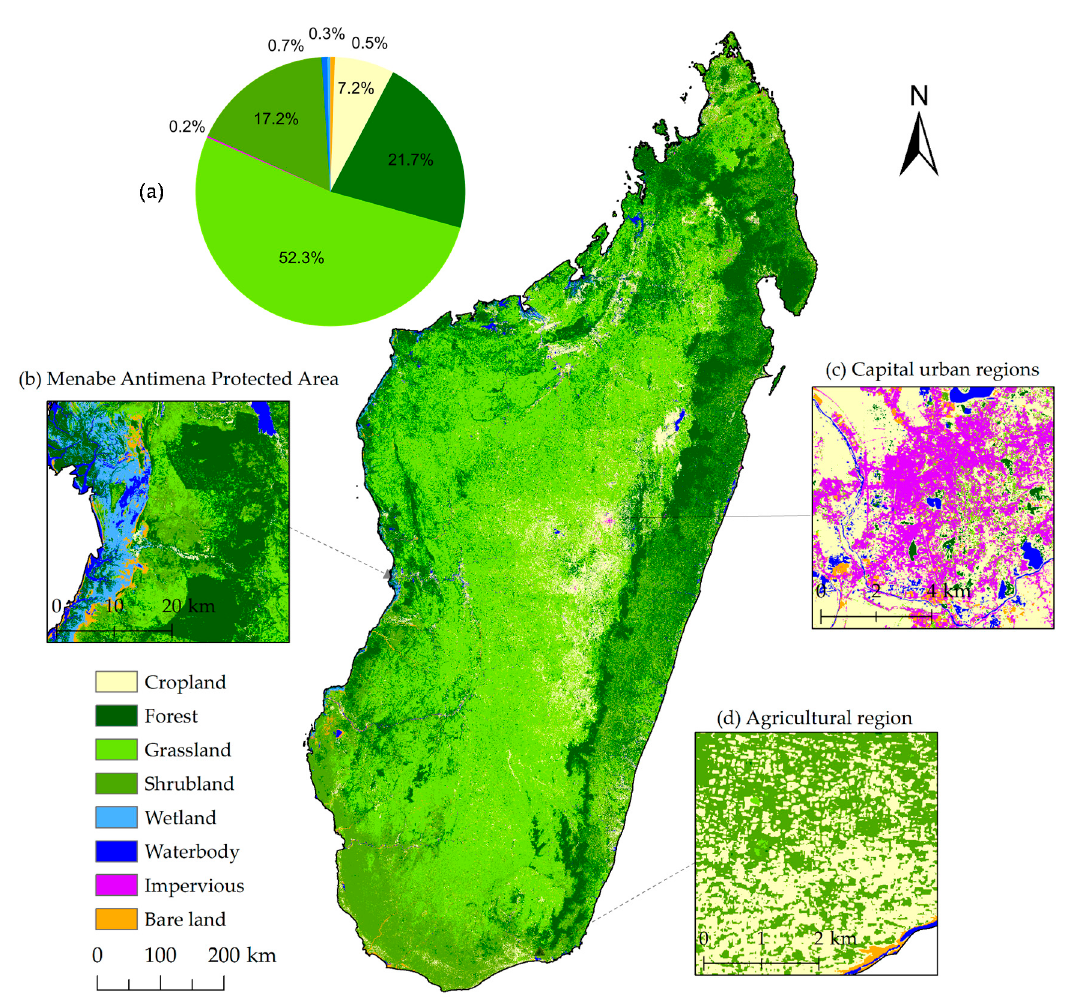
Figure 3. Overview of the 10-m circa 2018 land cover map of Madagascar (i.e., the MDG LC-10 map) derived from the Sentiel-2 dataset. ( a ) The proportions of the eight major land cover classes over the entire island. The zoomed in windows show the details ranging from the landscape view ( b ), the urban structure ( c ), and the fine grain land cover patterns ( d ). Table 2. Accuracy assessment of the MDG LC-10 map’s confusion matrix based on the independent validation samples.